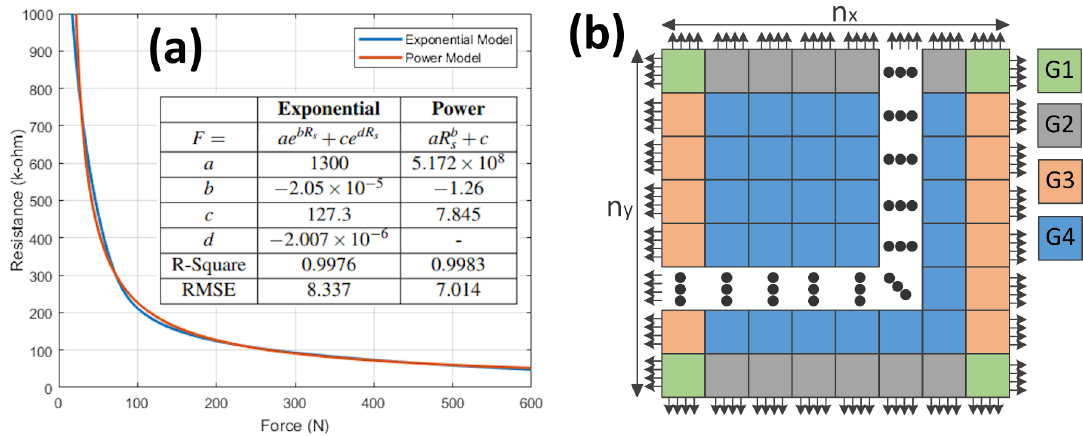
Figure 6. Prototype Data Acquisition System.